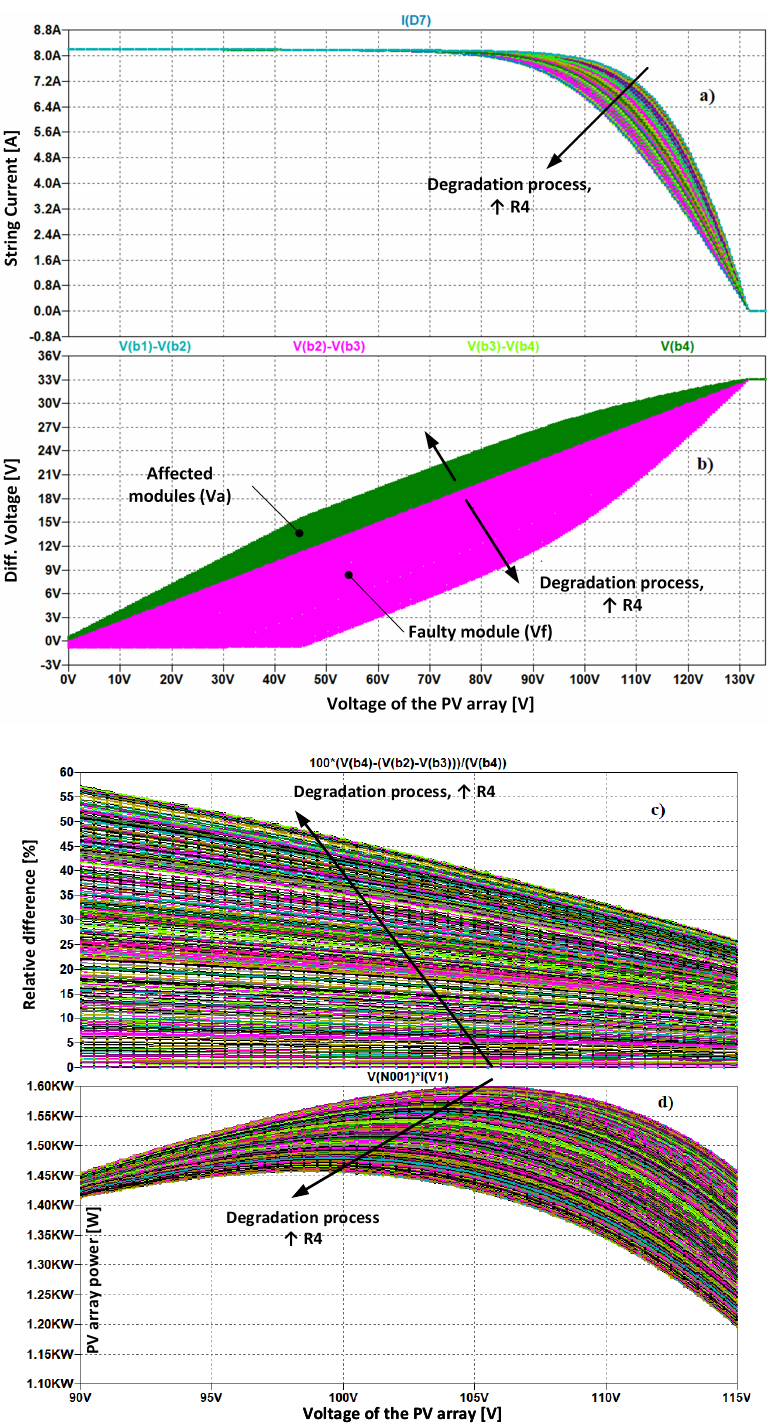
Figure 3. Series resistance degradation faults. This figure shows four charts as follows: ( a ) the current of the affected string versus the operating voltage of the array, ( b ) the differential voltage for all the modules in the affected string, ( c ) the relative percentage difference versus the operating voltage of the array, ( d ) peak behavior of output power in the array versus the operating voltage of the